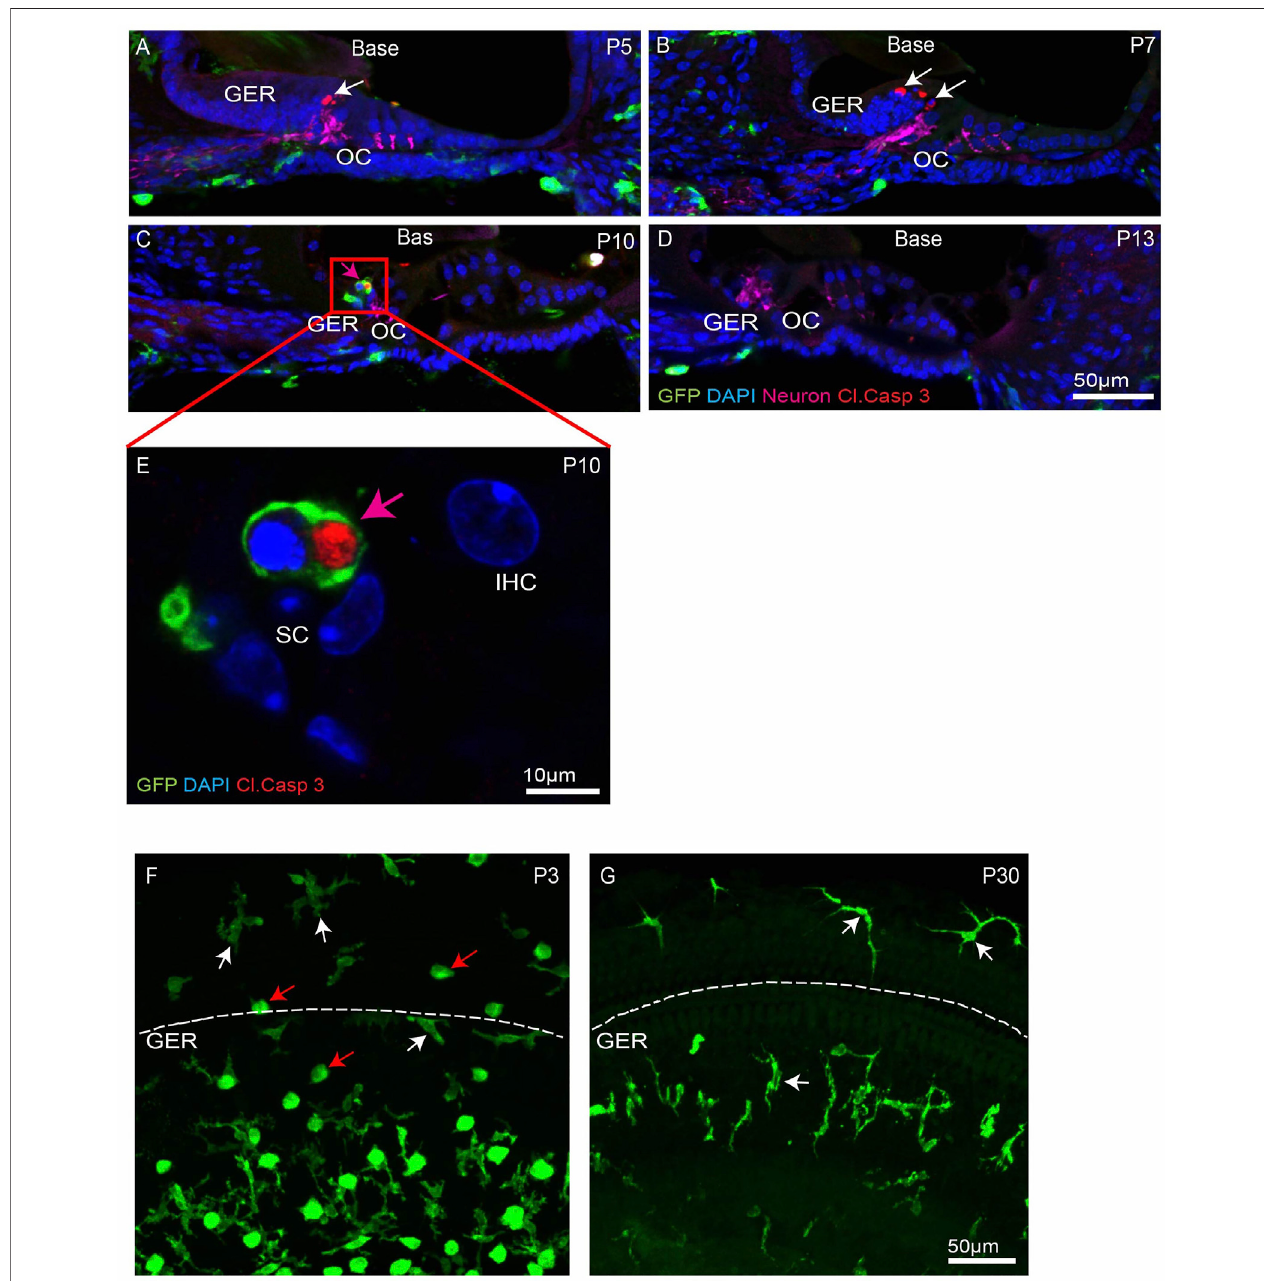
FIGURE 2 | Progression of apoptosis and macrophage in fi ltration in the basal region of the developing cochlea. (A – D) Mid-modiolar sections of the developing cochlea. Apoptotic cells (white arrows, cleaved caspase-3, red) were observed at P5-10. Such cells were often engulfed by macrophages (magenta arrow, GFP, green) (E) High magni fi cation image taken from organ of Corti (red box shown in C) showing GFP-labeled macrophage engul fi ng pyknotic nuclei at P10. (F – G) Presence of ameboid (red arrow) and rami fi ed (white arrow) macrophages in cochlear whole mounts. Note: GER region is present just below the dotted white line. Images in (A – D) , (F – G) were taken using a × 20 objective lens and the image in (E) was taken using a × 63 objective lens. Labels: Red-cleaved caspase- 3, Green-GFP + macrophages, Blue-DAPI. Abbreviations: OC: organ of Corti, GER: Greater Epithelial Ridge, IHC: Inner Hair Cell, SC: Supporting Cell (N (cid:2) 3 – 6).